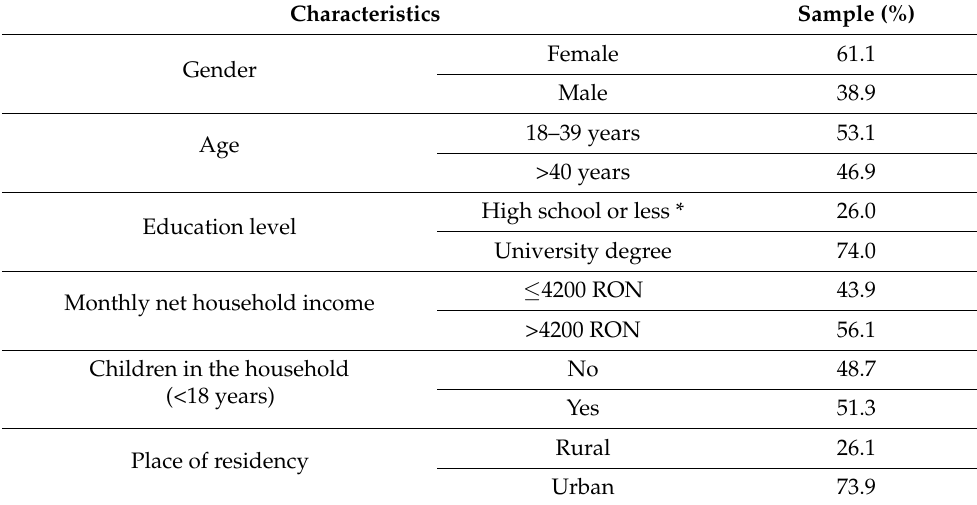
Table 1. Respondents’ socio-demographic